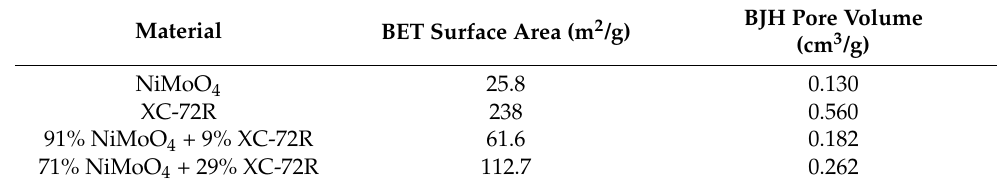
Table 1. The effect of CB loading on the surface area and pore volume of NiMoO 4 /CB mixtures. Material BET Surface Area (m 2